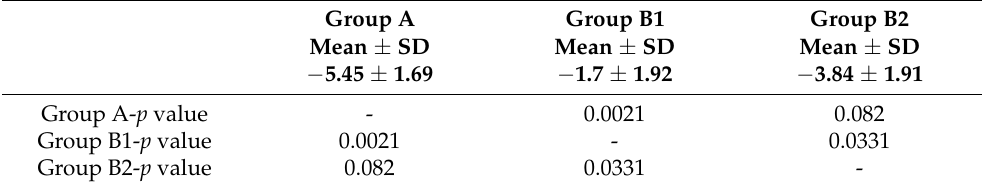
Table 3. Mean and standard deviation of Periotest values in paired comparison for all three protocols.